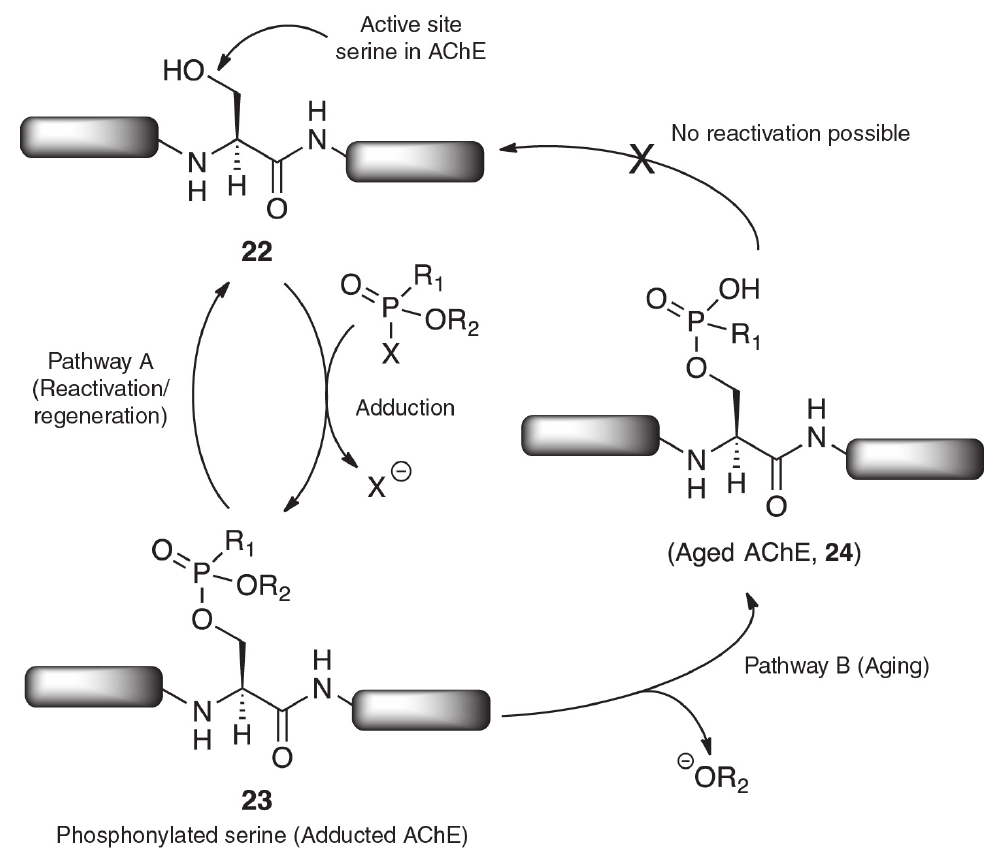
Figure 3: Proposed mechanism of action for the inhibition of AChE by nerve agents. Normal regeneration of AChE (Path- way A) can be accomplished after exposure to the agent (Adduction step); however, aging of the adducted enzyme (Path- way B) is also a possibility leading to a modified serine residue that cannot be regenerated via conventional oxime treat-